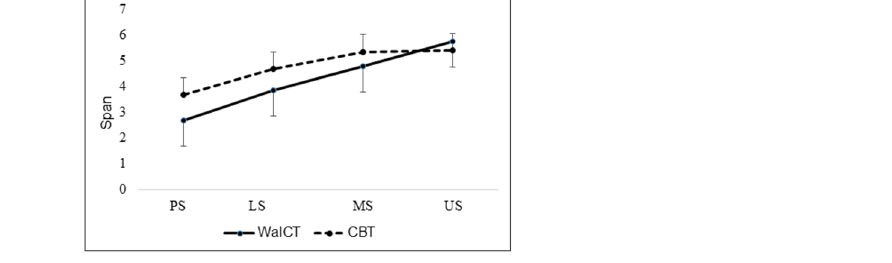
Figure 4. Topographical and visuospatial working memory at various school stages. PS = pre-school ( n = 27), LS = low stage ( n = 35), MS = middle stage ( n = 36), and US = upper stage ( n = 22).